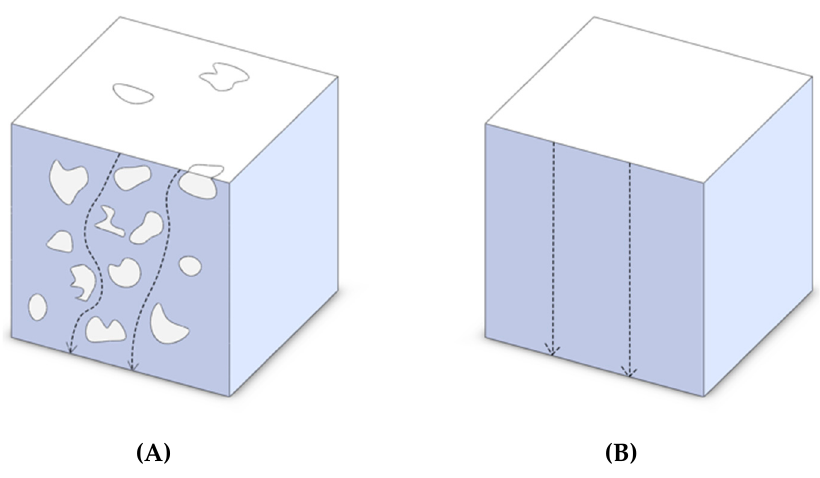
Figure 6. Electron path in ( A ) a porous and ( B ) a bulk metal.